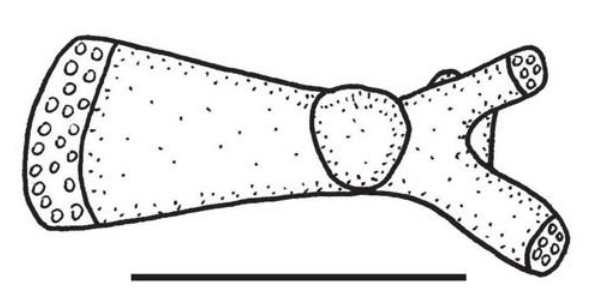
Fig. 2. Medial view (anterior to the left) of the autopalatine of Pseudobunocephalus lundbergi , ANSP 172505, paratype. Note forked posterior margin with two separate terminal cartilages (stippled with open circles). Scale bar equals 1 mm.